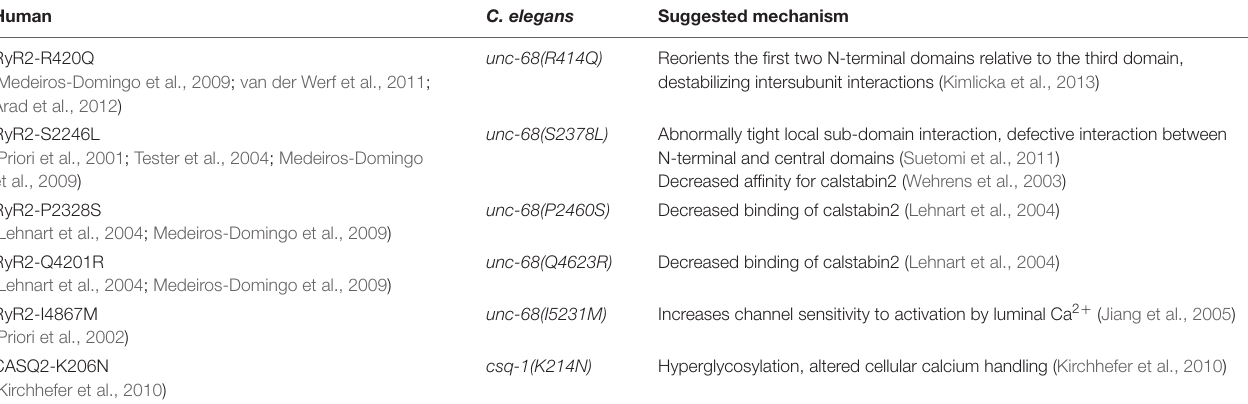
TABLE 1 | Catecholaminergic polymorphic ventricular tachycardia (CPVT) mutations found in human characterized in this study with their homologous sites in Caenorhabditis elegans unc-68 and their suggested mechanism. Human C. elegans Suggested mechanism RyR2-R420Q (Medeiros-Domingo et al., 2009; van der Werf et al., 2011; Arad et al.,